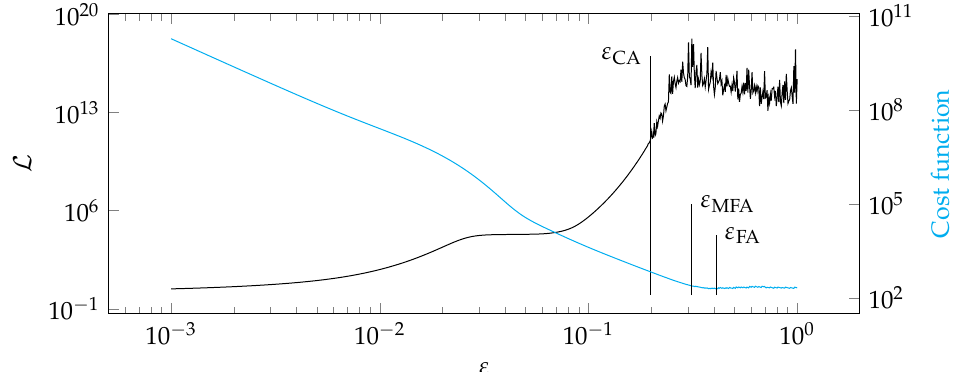
Figure 18. Graphs of the function L ( ε ) and the cost function for test case 3.